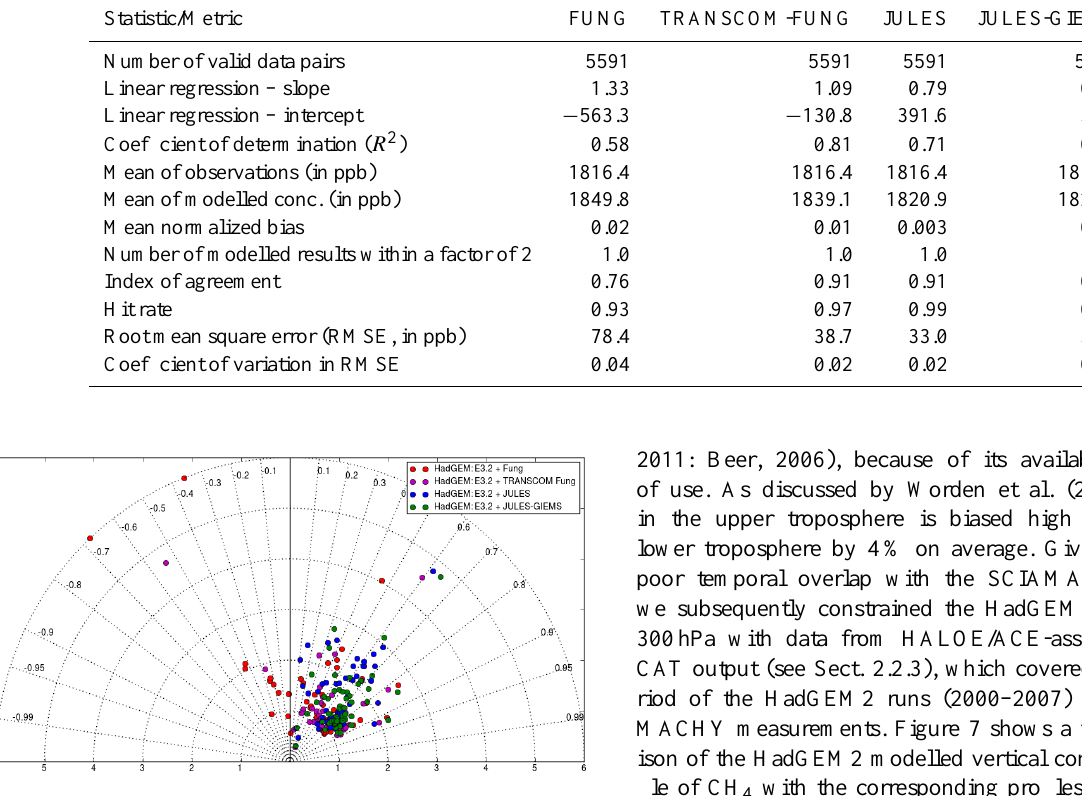
Figure 5. Taylor plot derived from the observed surface atmo- spheric methane mixing ratio (in ppb) and the HadGEM2 runs using the following wetland emission inventories, FUNG (red), TRANSCOM FUNG (magenta), JULES (blue) and JULES-GIEMS (green), for all valid data pairs from all